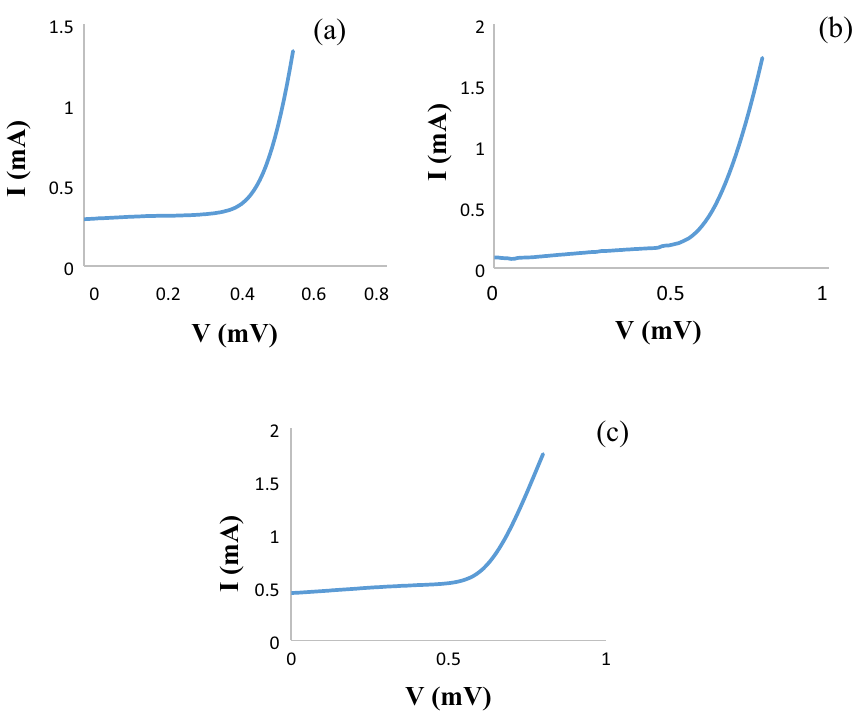
Figure 5. I–V graph ( a ) 1:1 TiO 2 @ZnO, ( b ) 2:1 ratio of TiO 2 @ZnO, ( c ) 2:1 ratio ZnO@TiO 2